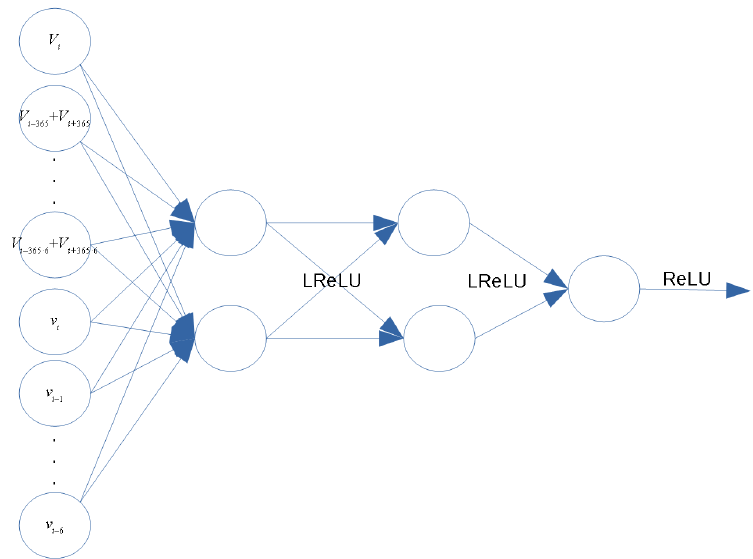
Figure 1. The topology of the MLPS